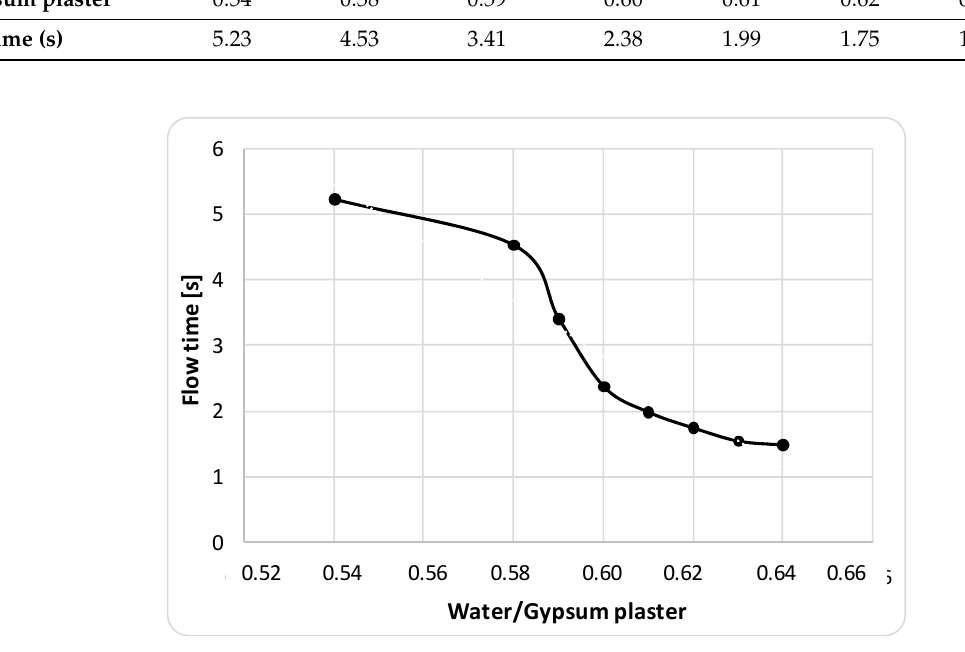
Figure 5. Flow time as function of water/gypsum plaster ratio.